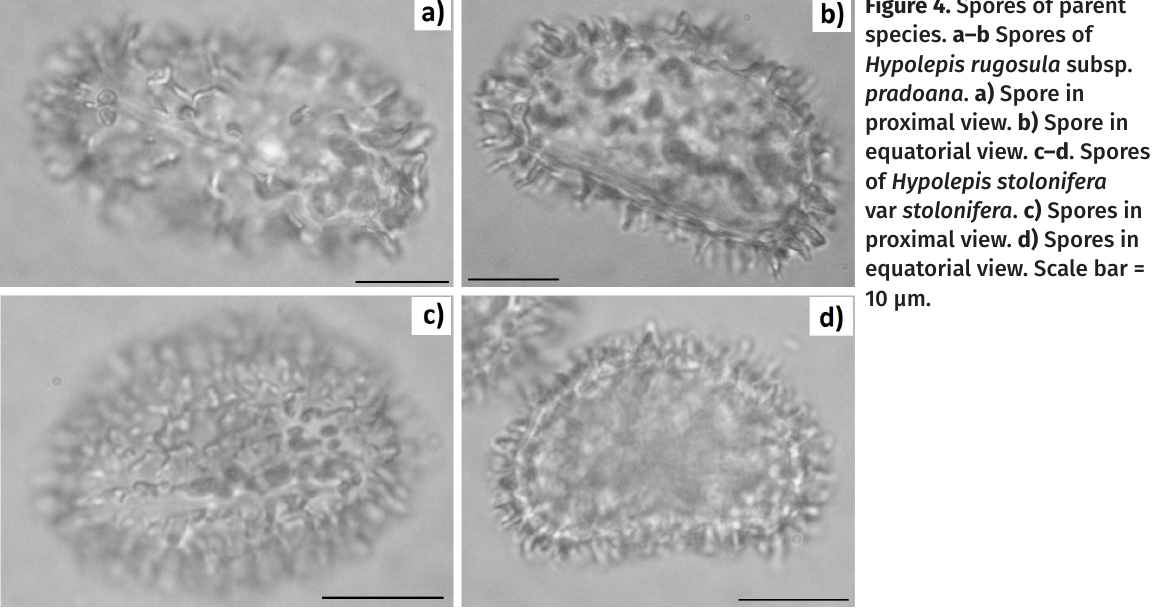
equatorial view. Scale bar =